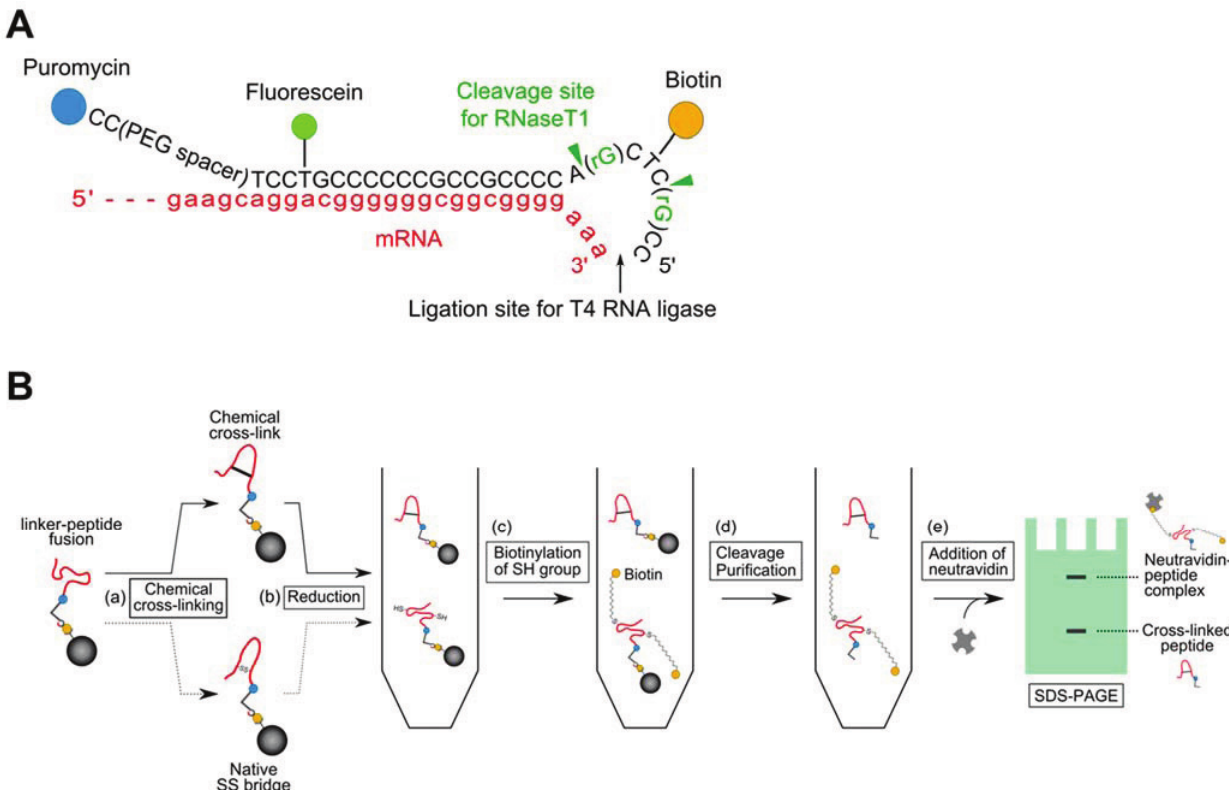
Figure 2. Introduction of a chemical cross-linker into a disulfide-containing